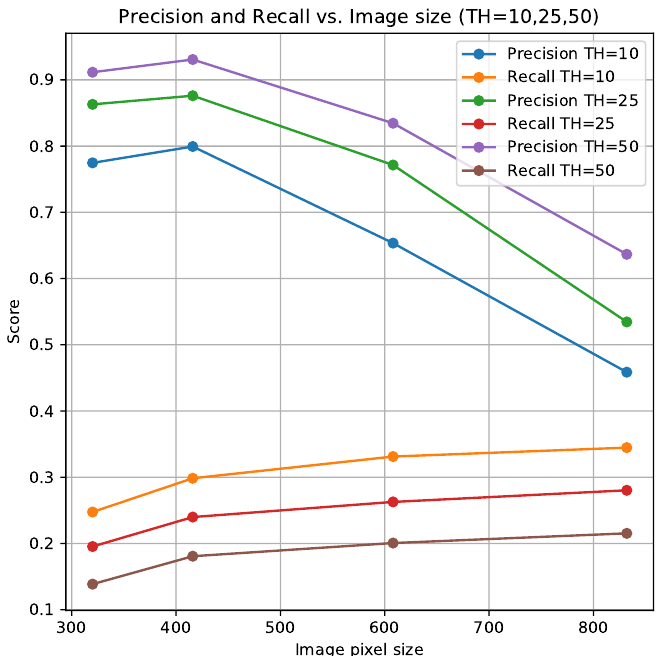
Figure 11. Average precision and recall as function of image size used by YOLOv3 to predict objects of six different plant species with a confidence threshold (TH) of 10%, 25% and 50% (see Supplementary Materials for a visual comparison of the image sizes).